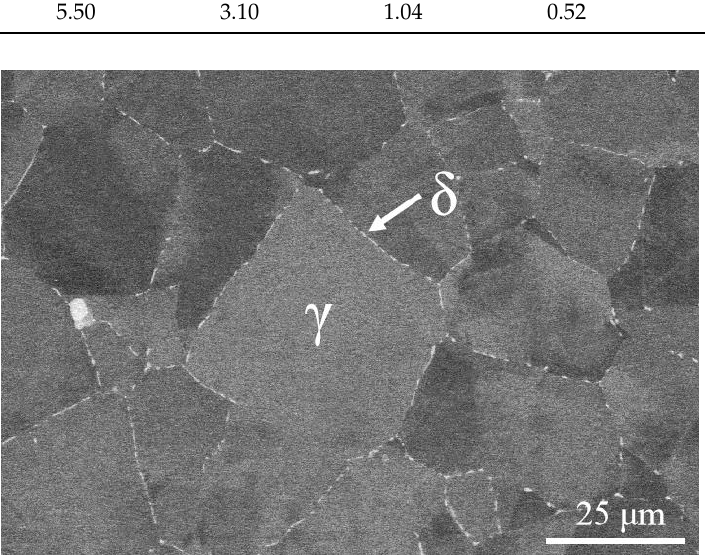
Figure 1. Microstructure of GH4169 superalloy.